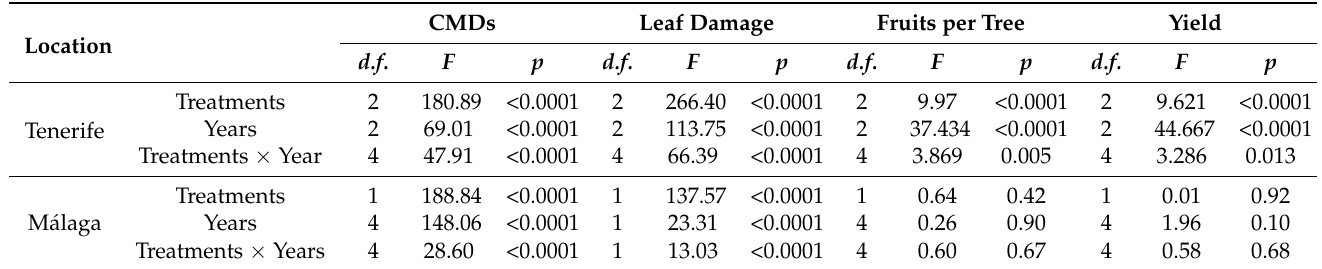
Table 3. Two-way ANOVA for CMDs (repeated measures) and for leaf damage, number of fruits, and yield for avocado trees subjected to three treatments during a period of three years (2011–2013) in Tenerife and two treatments during a period of five years (2011–2015) in M á laga.